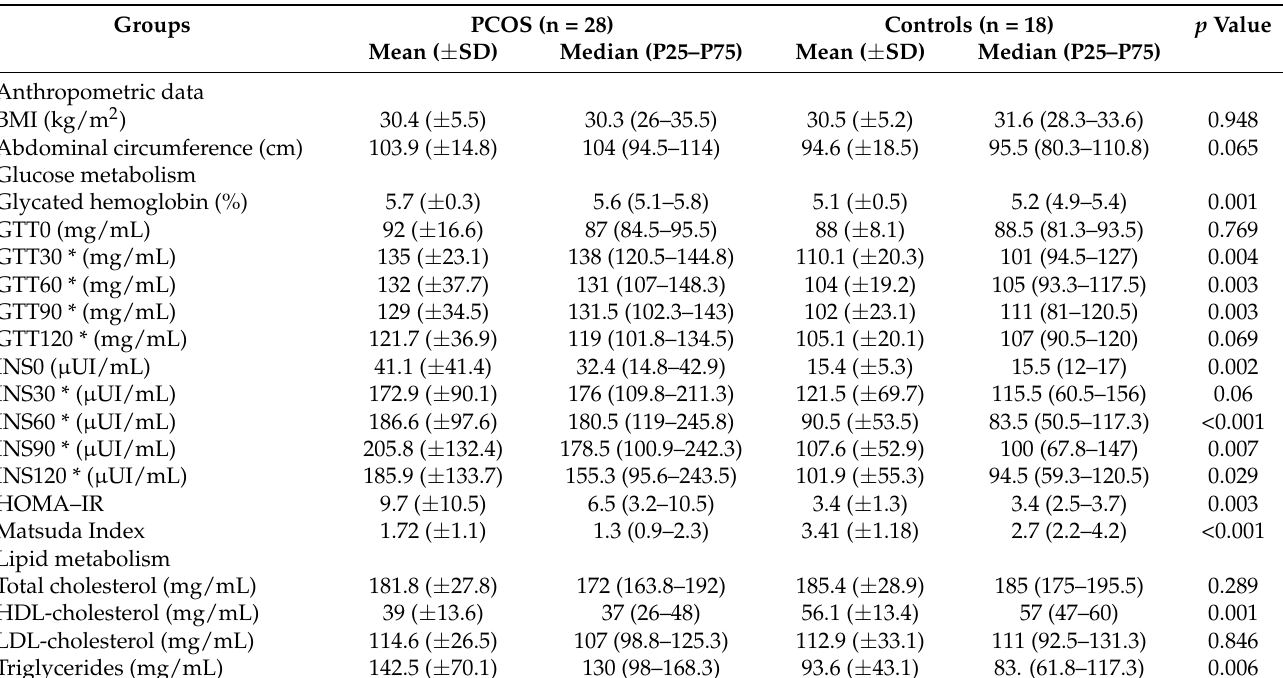
Table 2. Group-wise anthropometric features and data on blood pressure and lipid and glu- cose